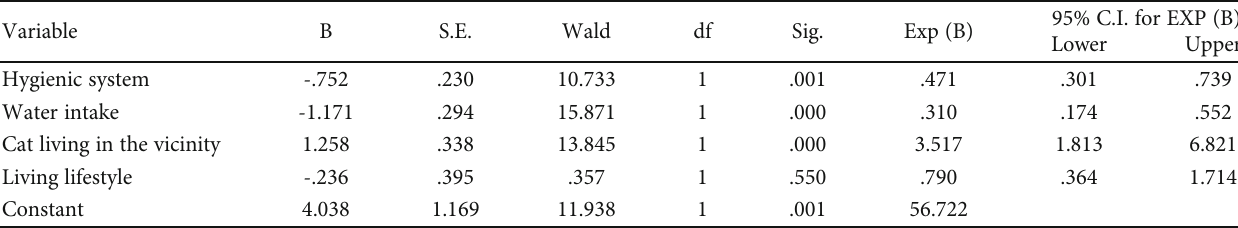
Table 5: Association of possible risk factors with IgG antibody of Toxoplasma gondii prevalence in ruminants using binary logistic model. Variable B S.E. Wald Water intake -1.171 Living